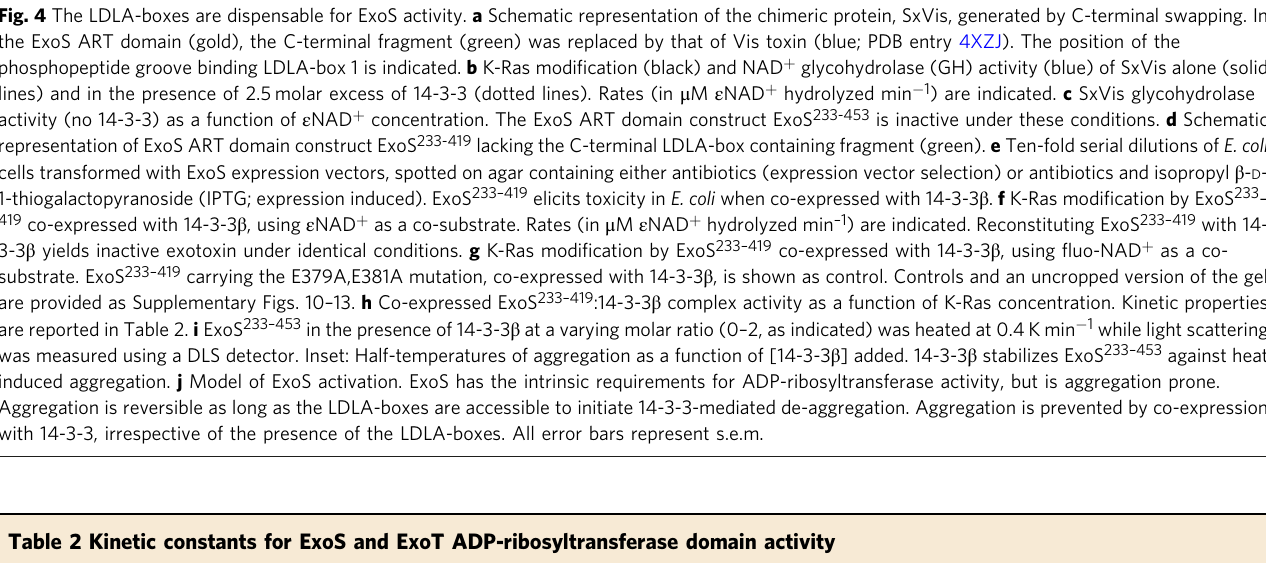
Fig. 4 The LDLA-boxes are dispensable for ExoS activity. a Schematic representation of the chimeric protein, SxVis, generated by C-terminal swapping. In the ExoS ART domain (gold), the C-terminal fragment (green) was replaced by that of Vis toxin (blue; PDB entry 4XZJ). The position of